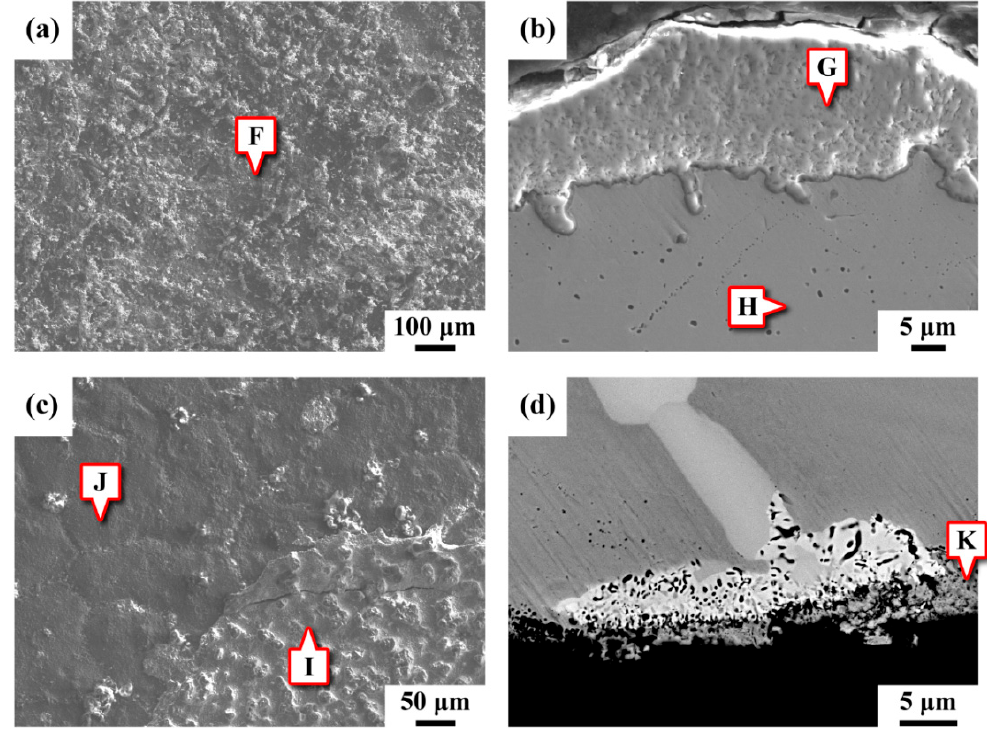
Figure 4. SEM micrographs showing the morphologies of the ( a , b ) external and ( c , d ) internal sections of the pipe in ( a , c ) top and ( b , d ) cross-sectional views. Table 3. Chemical compositions of sites F–K determined by EPMA in Figure